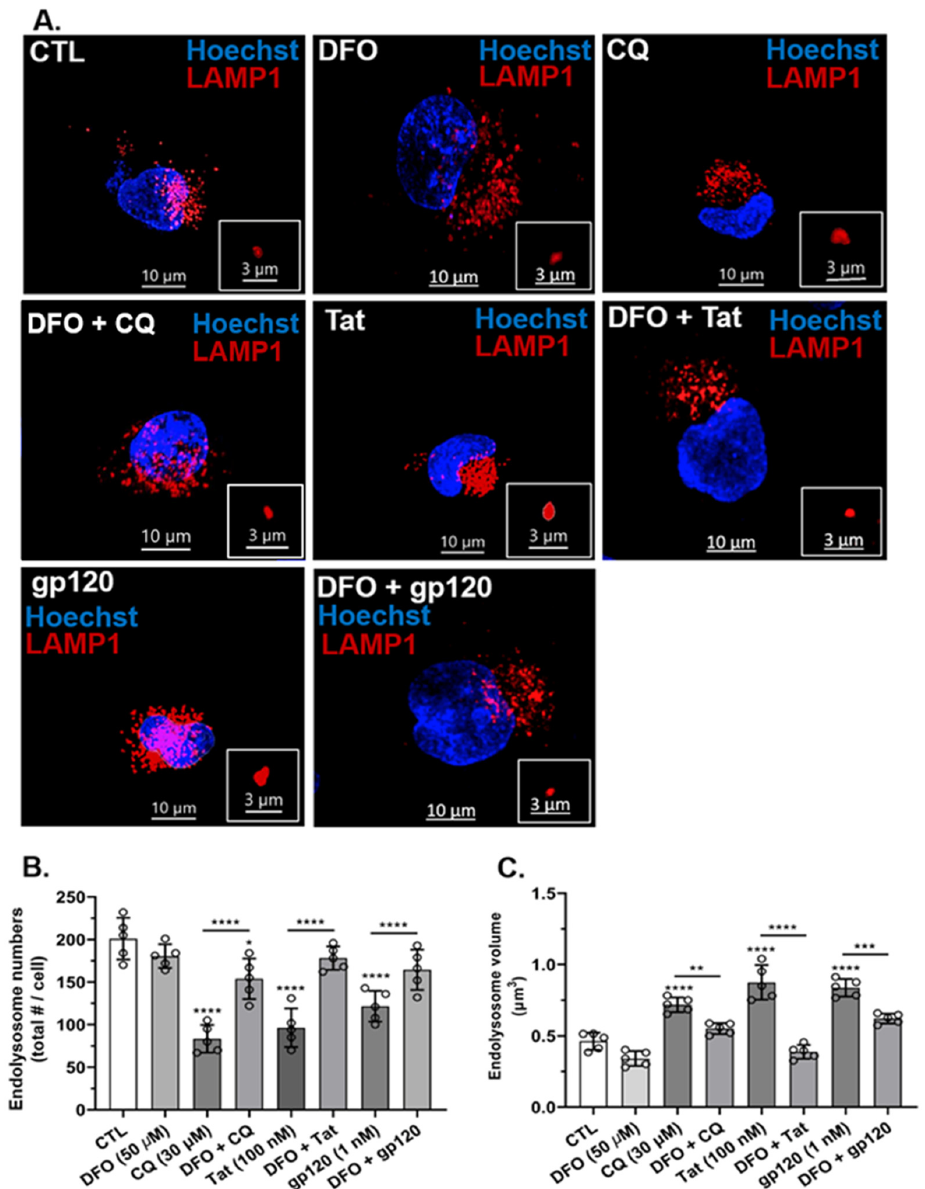
Figure 5. DFO blocked HIV-1 Tat-, gp120-, and CQ-induced decreases in endolysosome numbers and increases in endolysosome volume. ( A ) Representative fluorescence microscopy images showing endolysosomes (red puncta) and nuclei (blue) and that DFO blocked CQ- (30 µ M), Tat- (100 nM), and gp120- (1 nM) induced decreases in endolysosome numbers and increases in endolysosome volume. ( B , C ) Quantitatively, DFO blocked CQ-, Tat-, and gp120-induced decreases in endolysosome numbers and increases in endolysosome volume. Image analysis and quantification were performed from five independent experiments with 30 cells quantified for each experimental condition ( n = 150). Error bars represent standard deviation (SD) of five independent experiments. A one ‐ way ANOVA multiple comparisons test was used to compare control group and treatment group. Cells were chosen randomly during image acquisition and analysis from the microscope field of view, and no cells were intentionally excluded. Scale bars are 10 μ m for the image and 3 μ m for the inset. * p < 0.05, ** p < 0.01, *** p < 0.001 and **** p < 0.0001 .